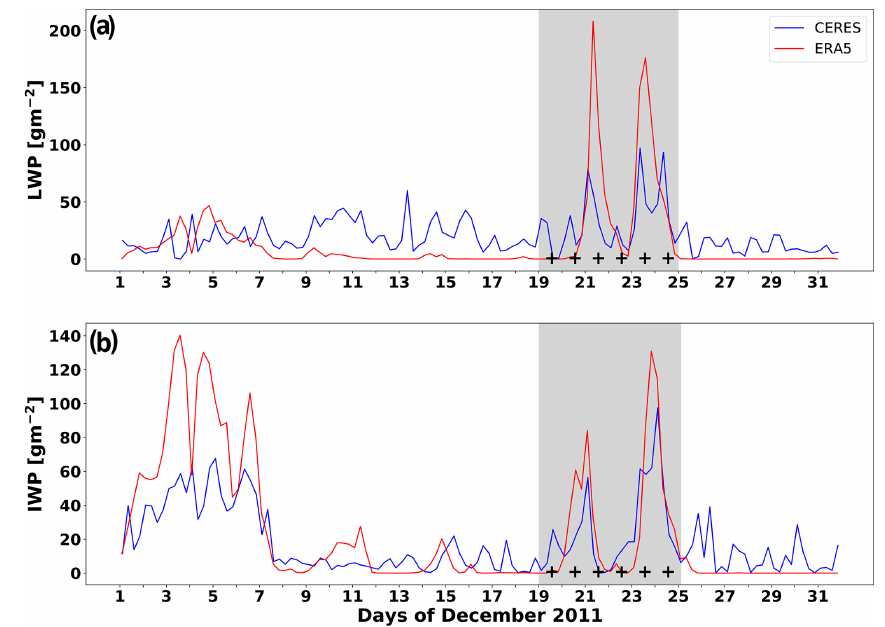
Figure 21. As in Fig. 5 but over the Pine Island and Thwaites Glacier region throughout December 2011.